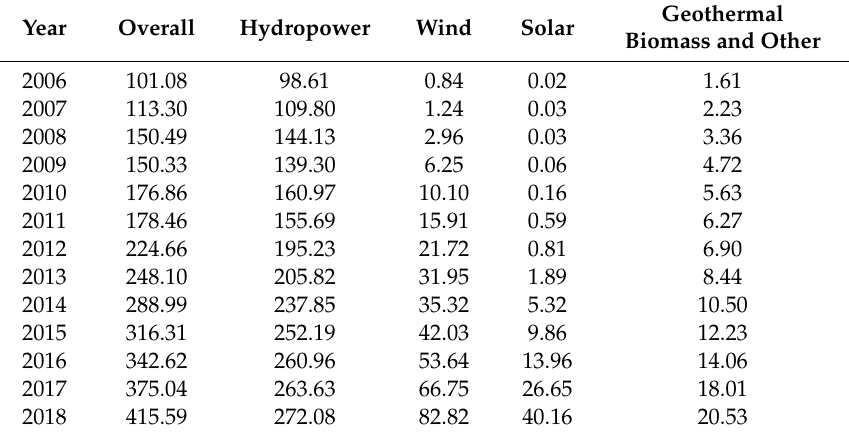
Table 3. The consumption data for China’s renewable energy from 2006 to